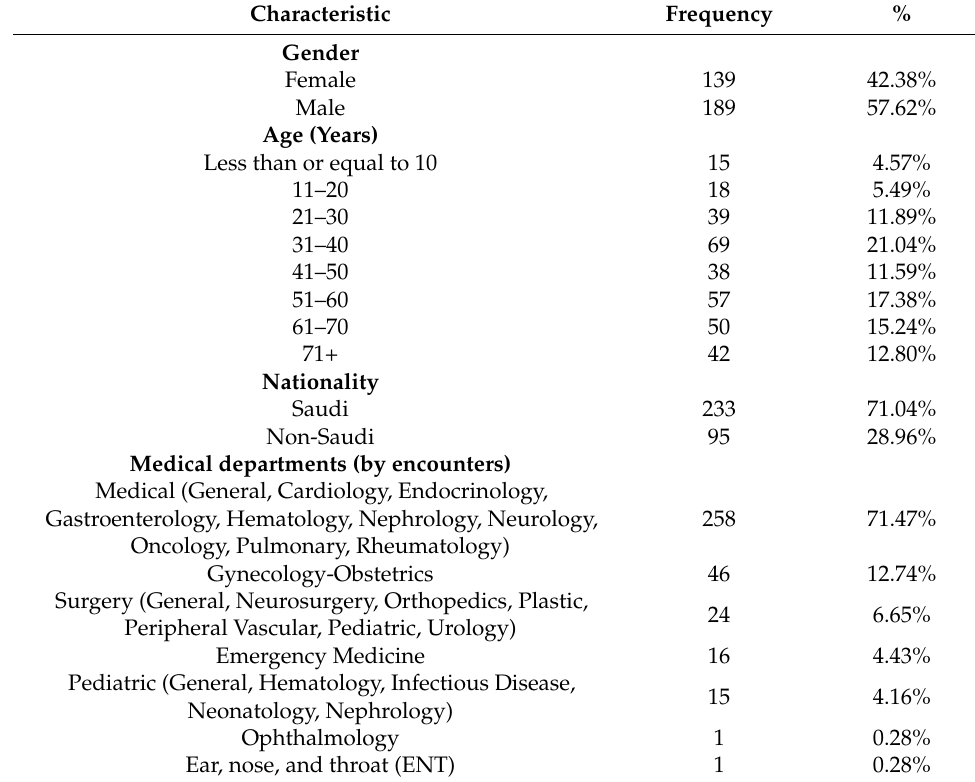
Table 2. Descriptive summary of COVID-19